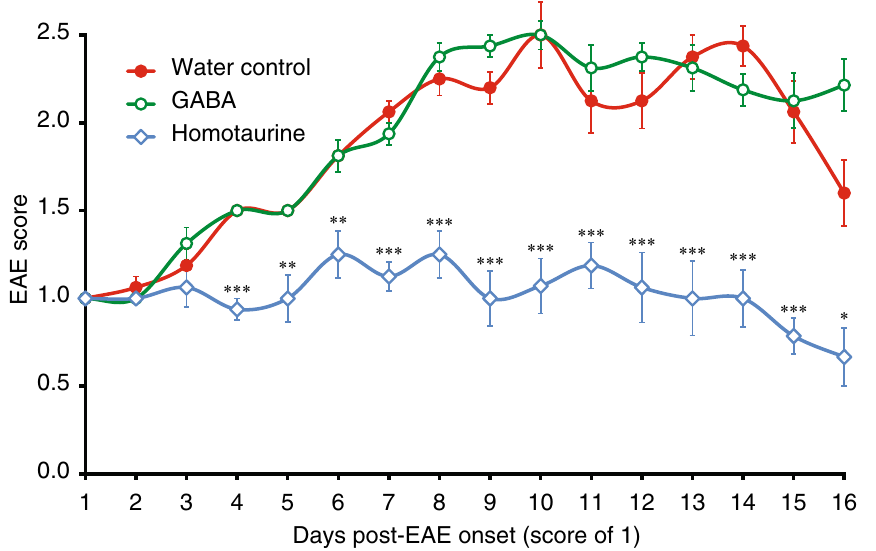
Figure 1. Homotaurine, but not GABA, limits the progression of EAE. C57BL/6 mice were immunized with MOG 35-55 and monitored daily for clinical signs of EAE as described in “Methods”. Eleven to thirteen days post-immunization all of the mice developed EAE. When the mice reached an EAE score of 1 they were randomized to receive plain, water containing GABA (6 mg/ml) or homotaurine (0.25 mg/ml) for the rest of the 16-day observation period. Graph shows mean EAE scores ± SEM for mice that received plain water (red solid circles), GABA (green open circles), and homotaurine (blue open diamonds) after EAE onset. N = 8 mice/group. *p < 0.05, **p < 0.01, ***p < 0.001 vs. plain water control group by Student’s t-test.